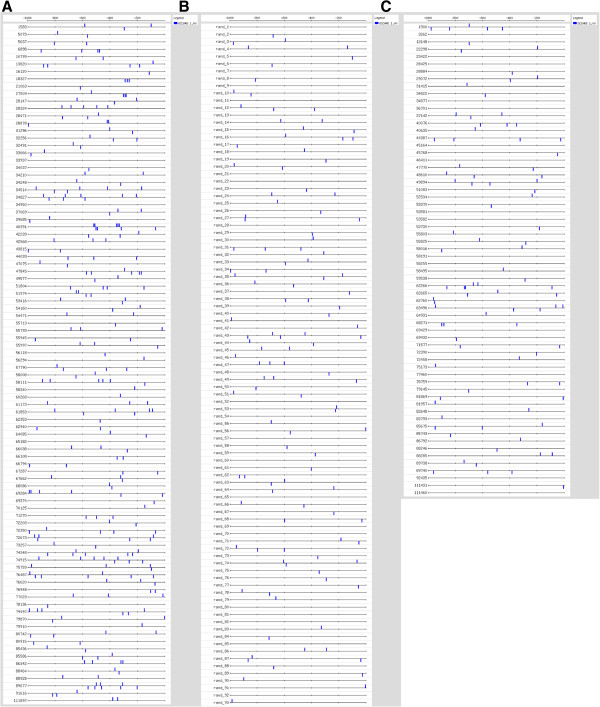
Identification of predicted binding sites for PacC. Binding sites for PacC in the 1 kb upstream of the start codon were identified using Regulatory Sequence Analysis Tools (RSAT, http://rsat.ulb.ac.be/). A. Promoters of genes upregulated in wt pH 8 vs. wt pH 4 and underexpressed in ΔpacC vs wt pH 8. B. Random promoter sequences from T. virens.C. Promoters of genes downregulated in wt pH 8 vs. wt pH 4 and underexpressed in wt vs. ΔpacC at pH 8.